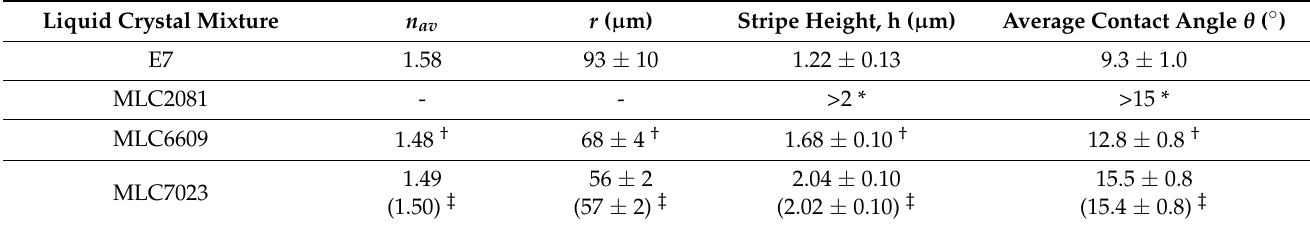
Table 2. Radius, height and contact angle values for w = 30 µ m wide